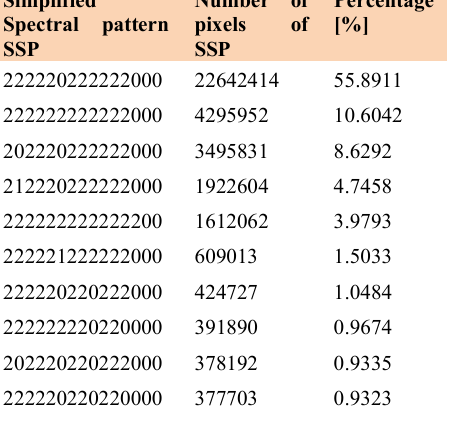
Table 1. Dominating SSP in the scene LC81270452013352LGN00 Pixels, that are not defined in the table of class definition, are filled after classification by spectral matching using the spectral similarity value.